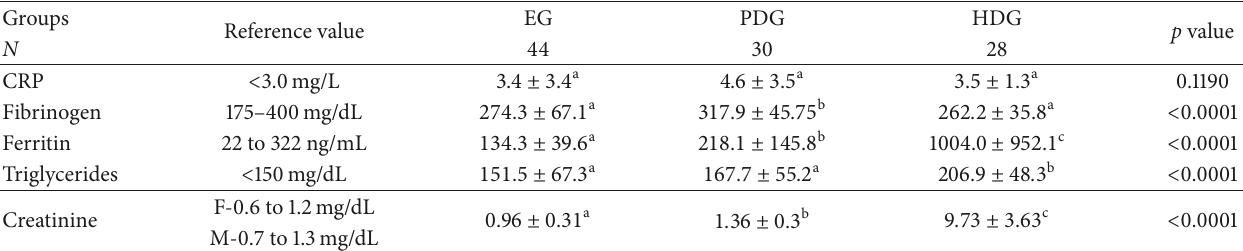
Table 3: Laboratory parameters of the patients according to study